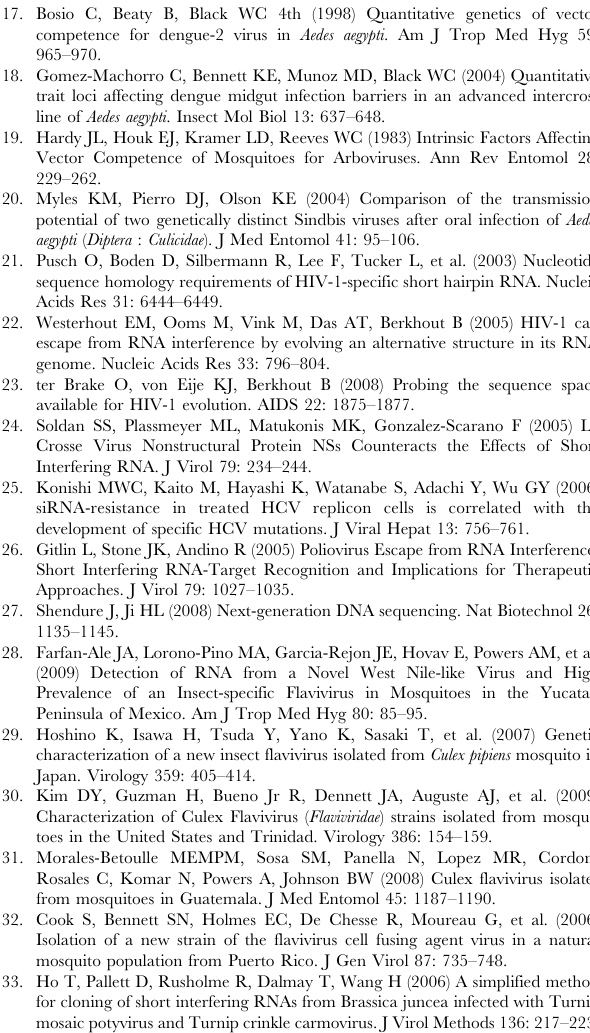
Figure S1 Intrahost mutational diversity and dN/dS, Pi and viRNA coverage. Table S1 Genetic diversity and selection in cloned WNV. * An alignment of 38 WNV genomes obtained from the North American epidemic was used to generate interhost diversity values. # Undefined. Only nonsynonymous mutations were